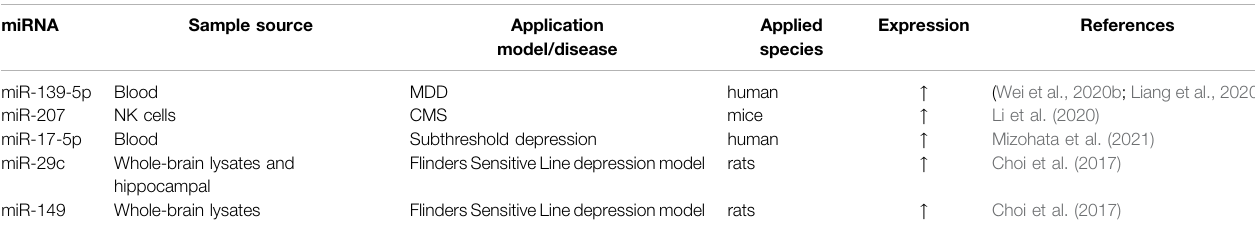
TABLE 1 | EV-associated miRNAs and their expression in DD.